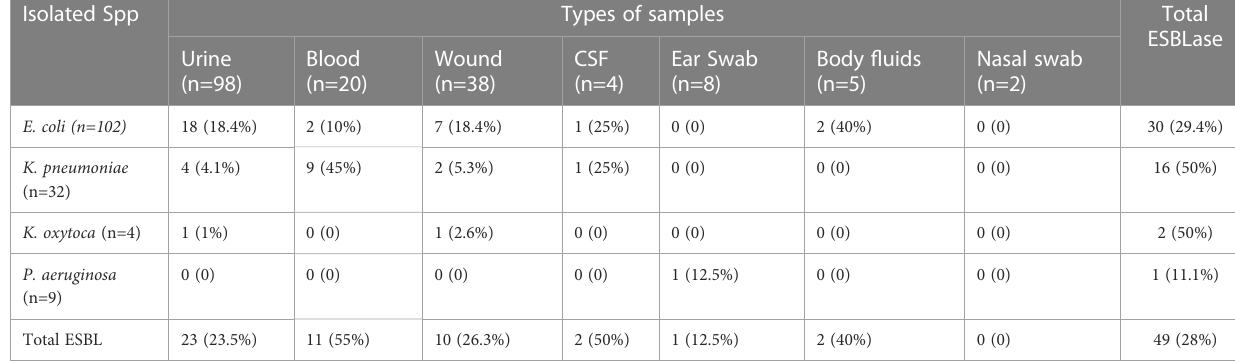
TABLE 5 Distribution of ESBLase producing Gram-negative bacteria in different isolated species and clinical